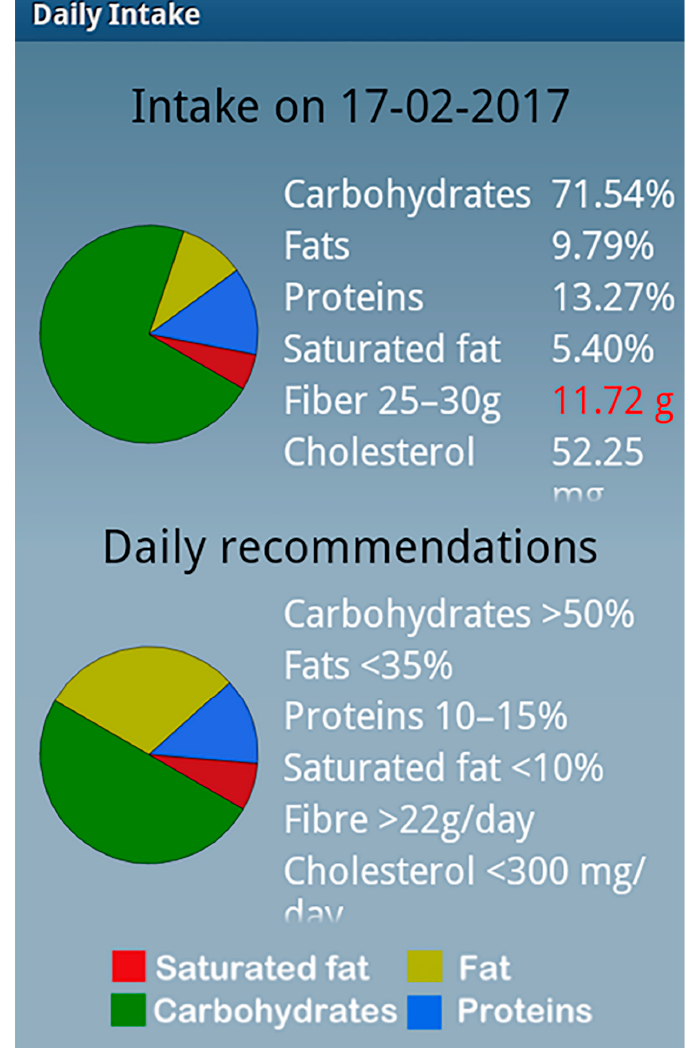
Figure 2. Screenshot of the personal recommendations made by the EVIDENT II diet application.